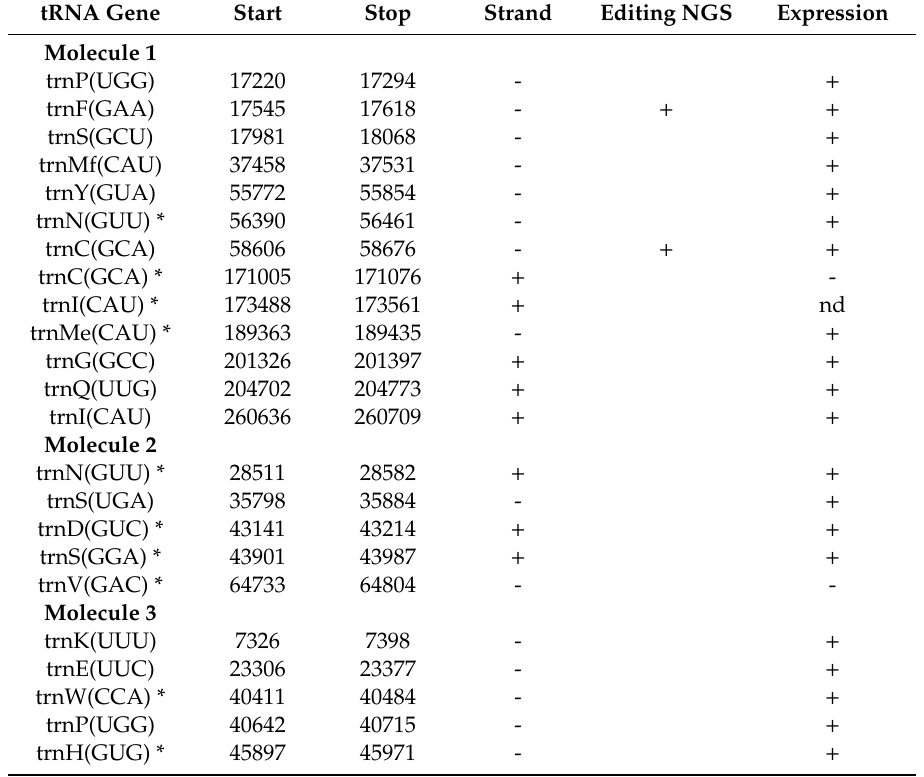
Table 2. List of tRNA genes. Plastid-like tRNA genes are tagged by ‘*’. Expression is according to [46]. Absence of expression for plastid-like Cys, and Val tRNA genes has been checked by northern blot (Figure S3). nd = not